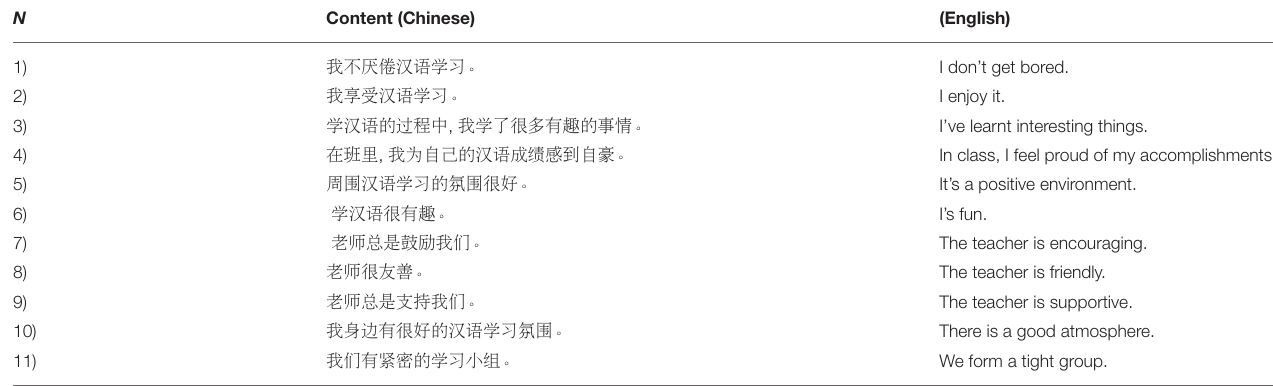
TABLE A1 | The Chinese version of the modified 11-item Foreign Language Enjoyment Scale (FLES), adopted from (Li et al.,